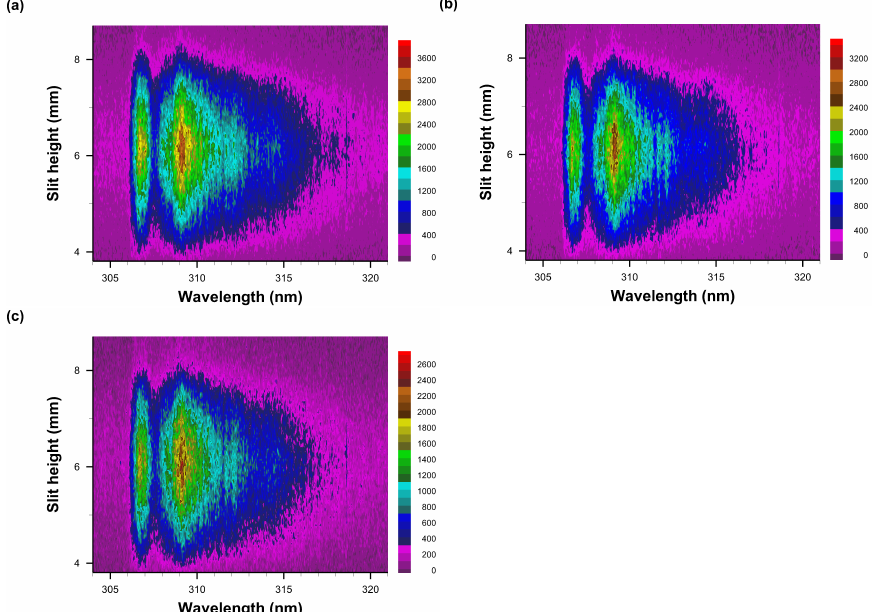
Figure 10. Recorded data of slit-height vs. wavelength. Gate width: 10 µ s, time delay ( a ) 90 µ s, ( b ) 100 µ s, and ( c ) 110 µ s. Each pseudo-colored image is scaled from minimum to maximum with intensity values as indicated next to the color bar.